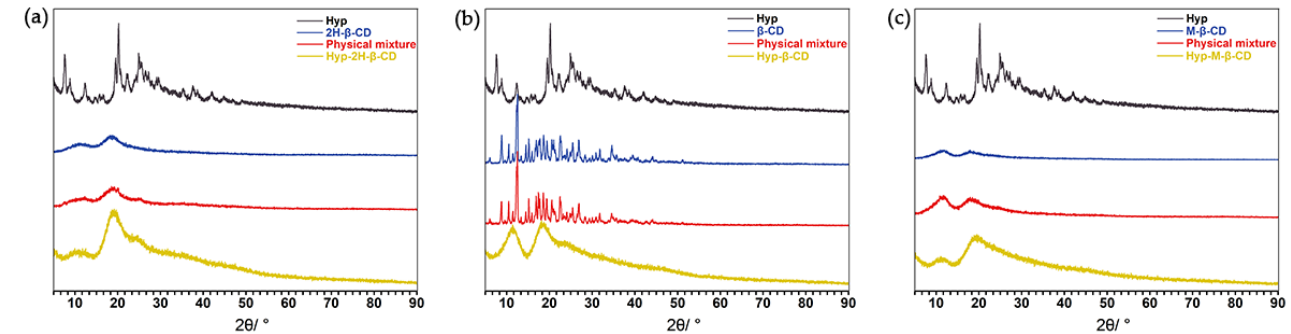
Figure 6. XRPD spectra of Hyp, CDs, physical mixtures, and the ICs. ( a ) Hyp/2H- β -CD complex system, ( b ) Hyp/ β -CD complex system, ( c ) Hyp/M- β -CD complex system.